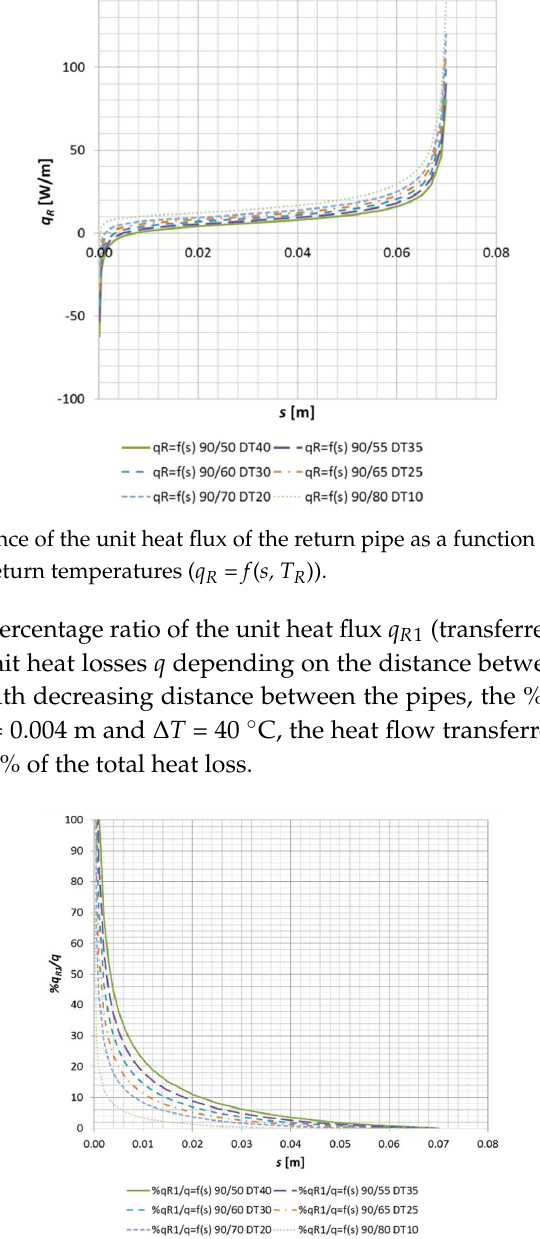
Figure 5. Percentage ratio of heat flux unit q R 1 (transferred from the supply pipe to the return pipe) to unit heat losses q depending on the distance between the pipes for different supply temperatures ( %q R 1 /q = f(s, T R ) ).